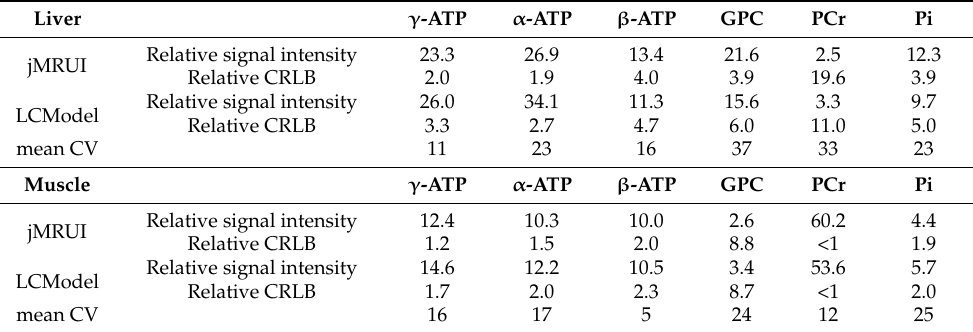
Table 2. Pilot comparison of the LCModel and jMRUI method calculation of means of relative signal intensities (%) and relative Cram é r Rao Lower Bounds (CRLB, %) of five liver and muscle spectra and means of their coefficients of variance CV (%) for the comparison. The BASIS p set was applied. Liver γ -ATP α -ATP